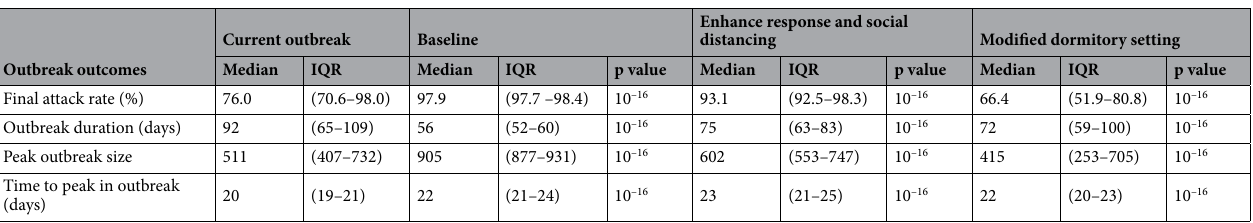
Table 2. Outbreak characteristics by intervention